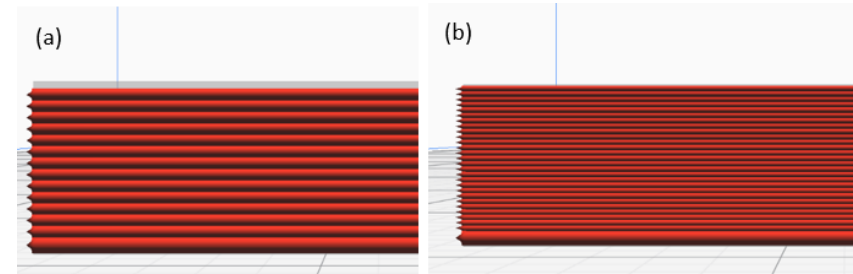
Figure 3. Layer thickness: ( a ) 0.10 mm ( b ) 0.20 mm .